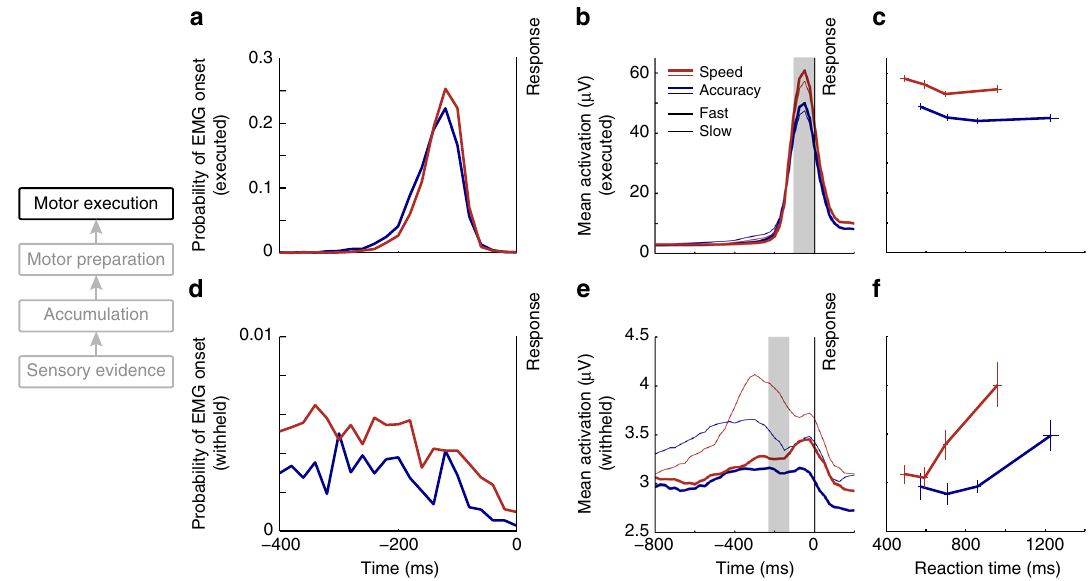
Fig. 6 Urgency induces graded changes in peripheral muscle activation. a – c Electromyographic (EMG) activity in the response-executing thumb. a Distributions of “ motor times, ” quantifying the time lag between muscle activation onset and action completion (button click), revealing shorter lags under Speed (red) than Accuracy (blue) emphasis. b Muscle activation (mean EMG spectral amplitude over 10 – 250 Hz measured in 100ms-time windows) time- locked to the button click response is increased under speed pressure, and for fast (thick traces) compared to slower (thin traces) responses. c Muscle activation during response execution (100 ms-time window before click, shaded gray in b is increased under speed pressure across all response time bins (Linear mixed-effects model: Regime: χ 2 (1) = 18.1, p = 2.1 × 10 − 5 , Supplementary Table 2c), and decreases signi fi cantly over reaction time bins (RT: χ 2 (1) = 5.4, p = 0.020; RT 2 : χ 2 (1) = 11.3, p = 0.0008). Error bars indicate S.E.M. across 16 subjects. d – f EMG activity in the response-withholding thumb. d In the response-withholding thumb, the probability of a muscle activation onset occurring without triggering a motor response (partial burst) is increased under speed pressure across a broad time range. e Mean spectral amplitudes measured in two response time bins show that, especially for late responses (thin traces), response-locked traces of muscle activation in the response-withholding hand show increased activation under speed pressure (red traces). f With increasing response time, muscle activity in the response-withholding thumb increases both under Speed and Accuracy emphasis in a time window just prior to the mean EMG onset time in the response-executing thumb ( − 225ms to − 125ms, shaded in e ). Note that activation in the response-withholding hand is plotted on a much smaller scale than that of the response-executing hand. Error bars indicate S.E.M. across 16